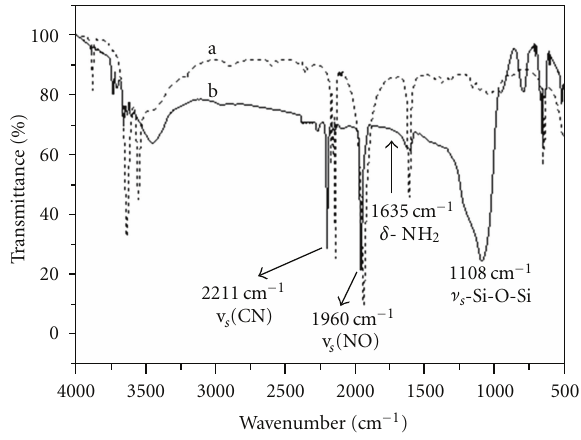
Figure 2: FTIR of (a) NP and (b) CuNPSD.